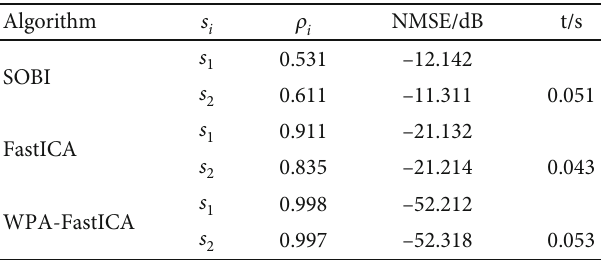
(b) The separated frequency domain signals with di ff erent noises by WPA-FastICA Figure 6: Time-frequency waveforms signals of the WPA-FastICA algorithm. Table 1: Comparison of evaluation indexes of blind source separation at SNR